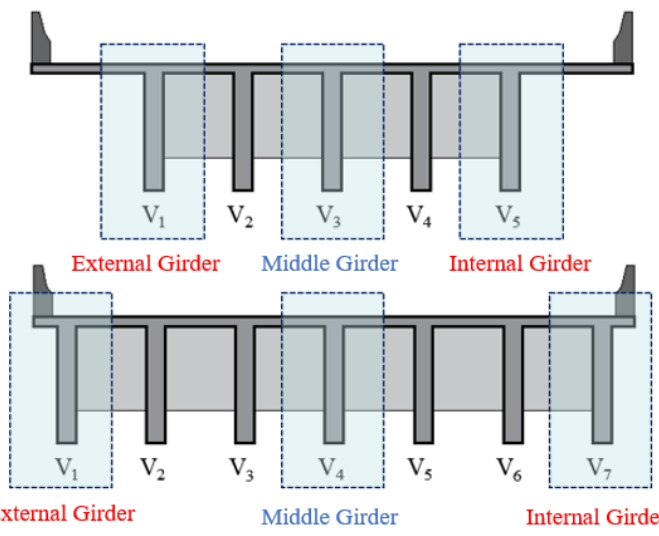
Figure 16. Girders considered for the attainment of Modification